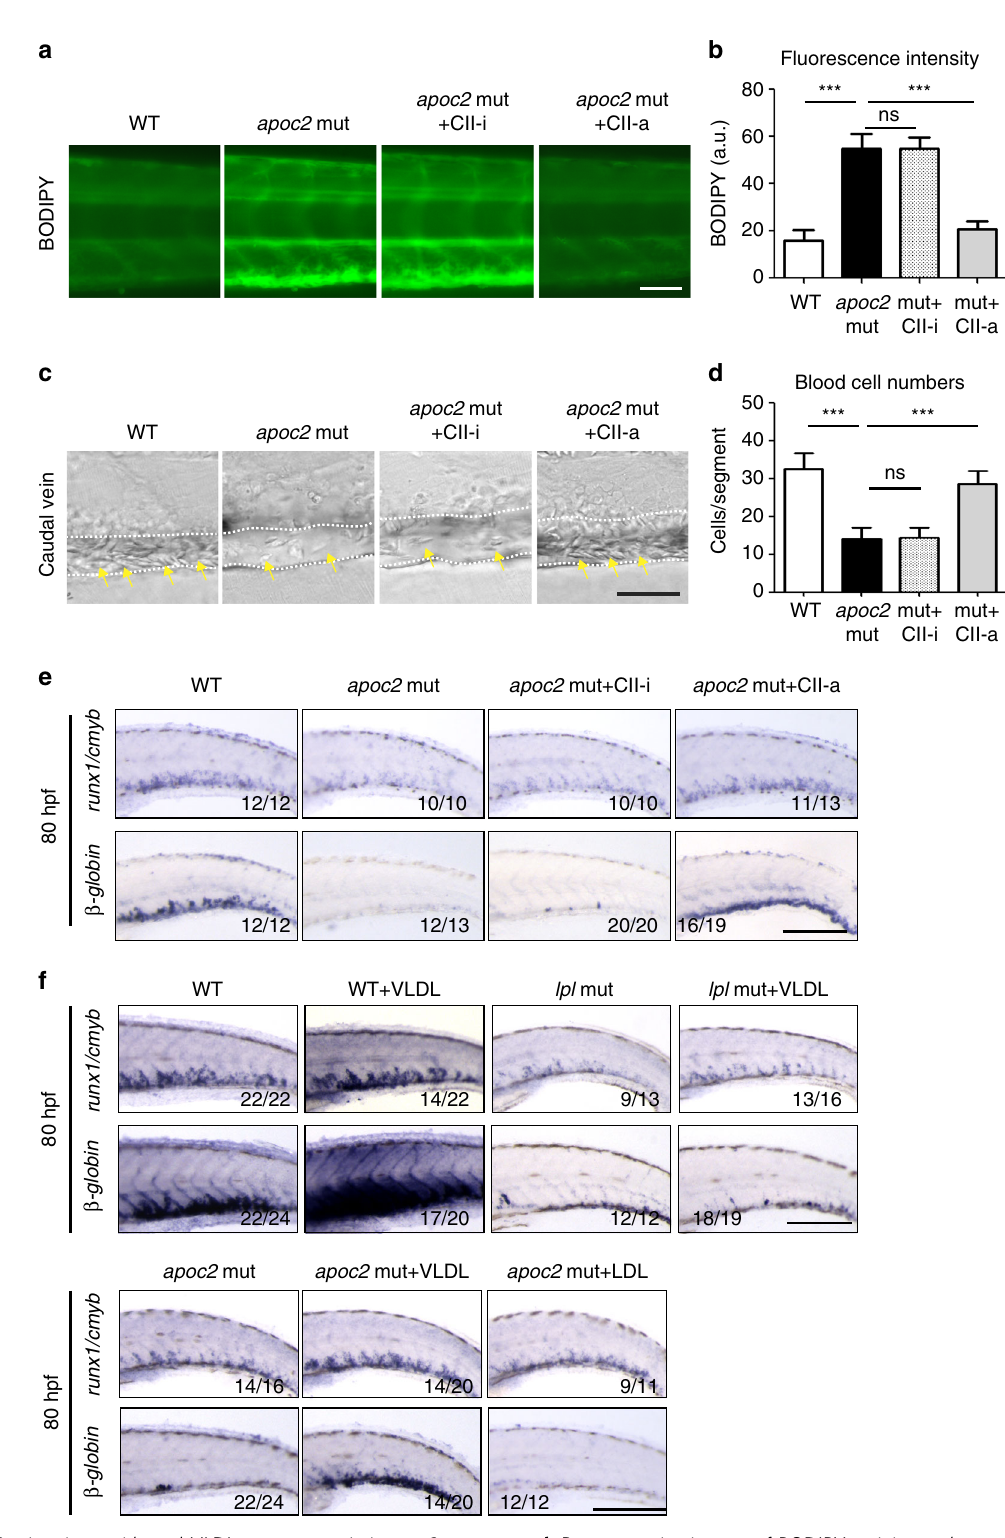
Fig. 4 APOC2 mimetic peptide and VLDL rescue anemia in apoc2 mutants. a , b Representative images of BODIPY staining and quantitative results of BODIPY fl uorescence intensity in WT, apoc2 mutants and the apoc2 mutants injected with APOC2 mimetic peptides (CII-a, active; CII-i, inactive) at 6.3 dpf ( n = 5 in each group). c , d Representative images of blood cells in the caudal vein region and quantitative results of blood cell count in WT, apoc2 mutants and the apoc2 mutants injected with APOC2 mimetic peptides at 6.3 dpf ( n = 6 in WT and mut + CII-i goups each; n = 8 in apoc2 mut group; n = 7 in mut + CII-a group). e In situ hybridization with cmyb/runx1 and β -globin probes in WT, apoc2 mutants and the apoc2 mutants injected with APOC2 mimetic peptides at 80 hpf. Embryos were injected with peptides at 2 dpf. f In situ hybridization with cmyb/runx1 and β -globin probes in WT, apoc2 and lpl mutants, including those injected with VLDL or LDL at 2 dpf. Embryos were analyzed at 80 hpf. Scale bars, 50 μ m in a and c ; 200 μ m in e and f . Mean ± SEM; *** P < 0.001 (Student ’ s t